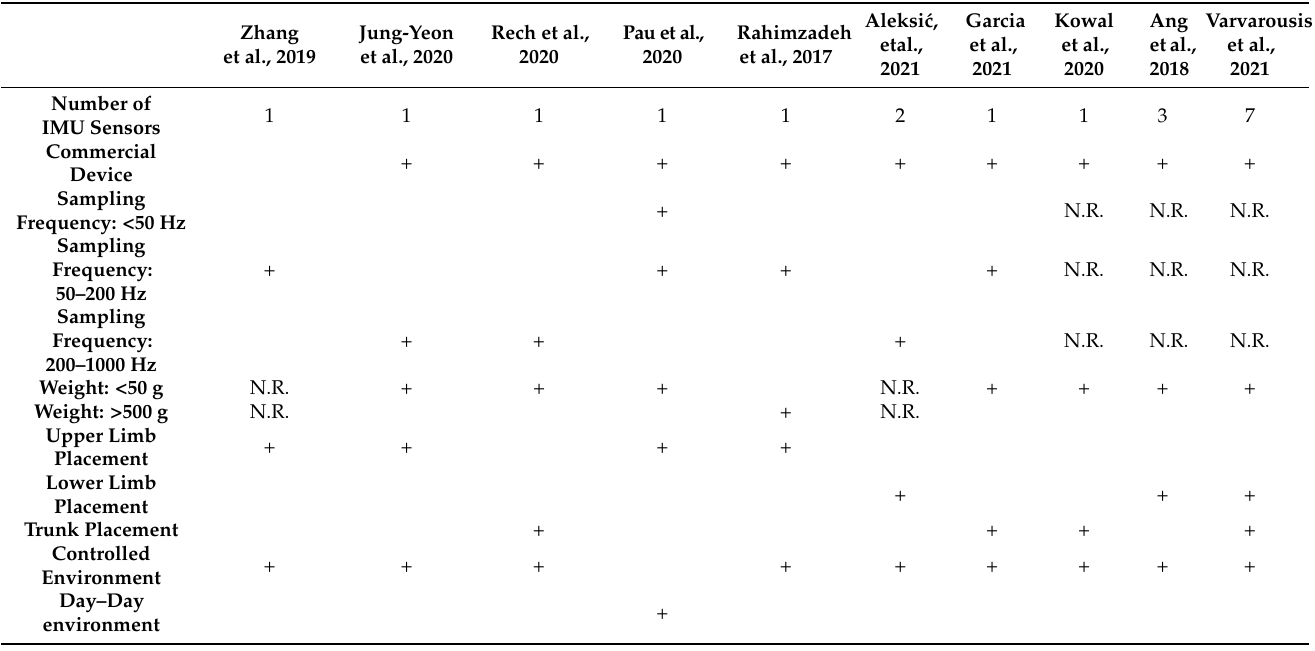
Table 4. Summary of IMU characteristics and